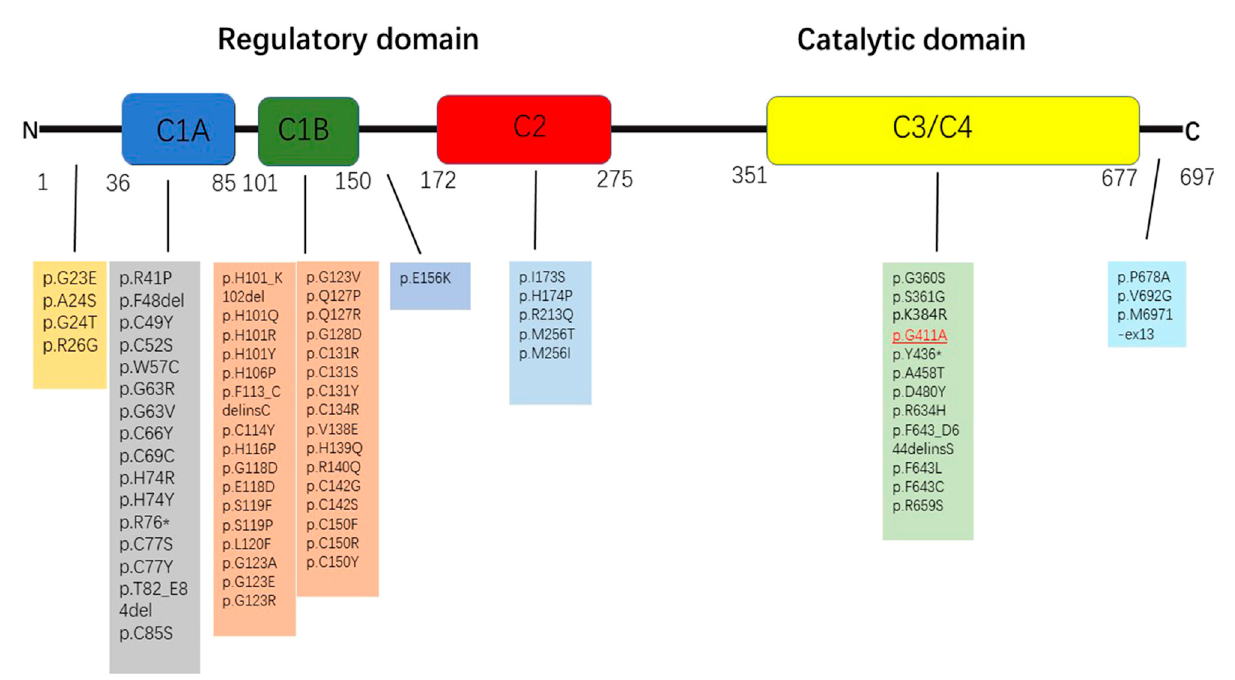
FIGURE 3 VariantsassociatedwithataxiathataredescribedintheproteinkinaseC γ codedby PRKCG .Thepathogenicorlikelypathogenicvariantsidenti fi edin this study are highlighted in